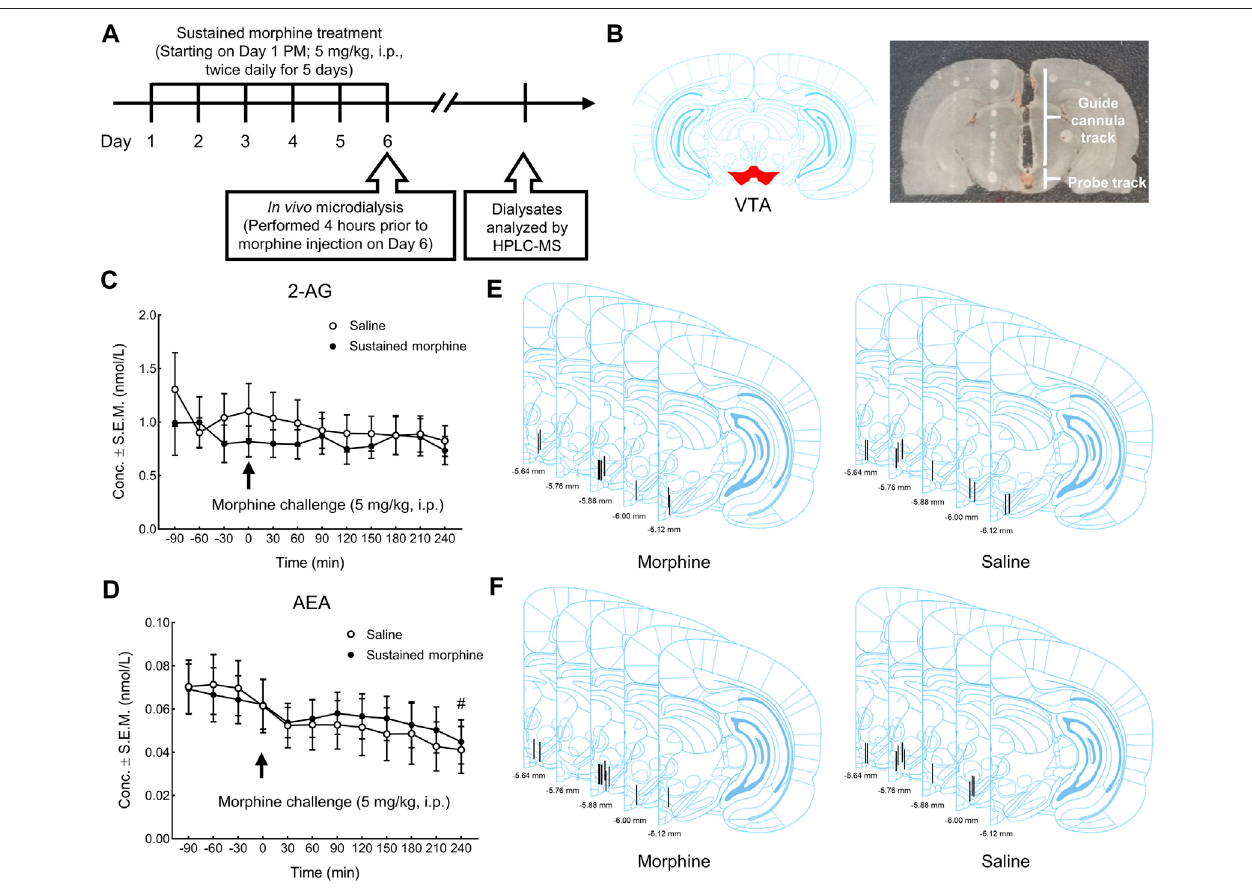
FIGURE 4 | The effects of sustained morphine on the production of 2-AG and AEA in the VTA. In vivo microdialysis was performed on rats one day after repeated morphine treatment to determine the alterations of endocannabinoids in VTA. Microdialysis samples were collected every 30 min for a total of 6 h. After the fi rst 2 h baseline( t (cid:1)− 120 – 0 min), all ratsreceived anadditional injection ofmorphine and the changes inthe production of endocannabinoids wasobservedfor the next4 h( t (cid:1) 0 – 240 min). (A) Experimental design for in vivo microdialysis of endocannabinoids. (B) Representative brain section of microdialysis guide cannula/probe implantation. (C, D) no signi fi cant difference in the production of either 2-AG or AEA was observed between treatment groups at baseline session or in the morphine challenge session. However, a signi fi cant time effect in AEA production was observed between the baseline period and the last time point of the morphine challenge session (t (cid:1) 240 min). (E, F) Anatomical representatives of microdialysis guide cannula placements in VTA for the studies of 2-AG and AEA. # p < 0.05, t (cid:1) 240 min vs. baseline ( t (cid:1) − 90 to 0 min). Values represent the mean ± SEM, n (cid:1) 9 – 10 per